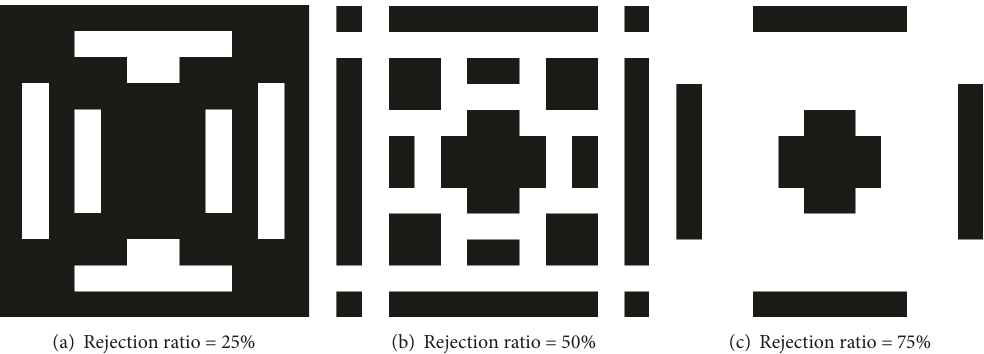
Figure 13: Optimal CLD layouts obtained using GA under various rejection ratios for second BC.